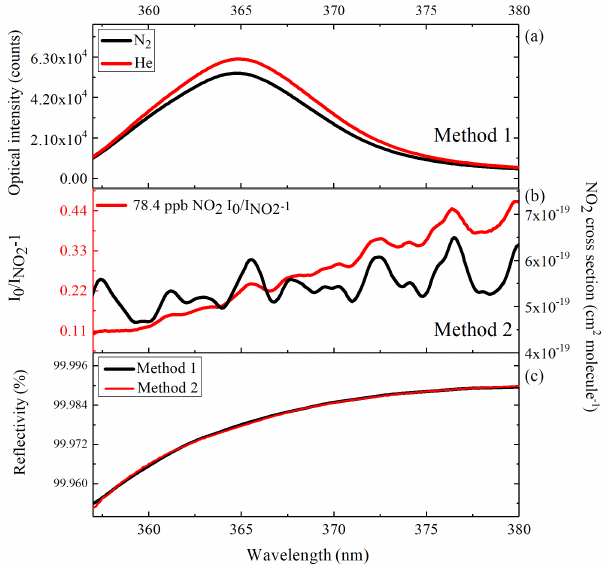
Figure 2. (a) The red curve is the transmitted intensity spectrum when the cavity is filled with He, and the black curve is that when the cavity is filled with N 2 ; (b) the red curve is the absorption spec- trum of 78.4ppb NO 2 seen by IBBCEAS, and the black curve is the NO 2 cross section; (c) the derived curve of mirror reflectivity.